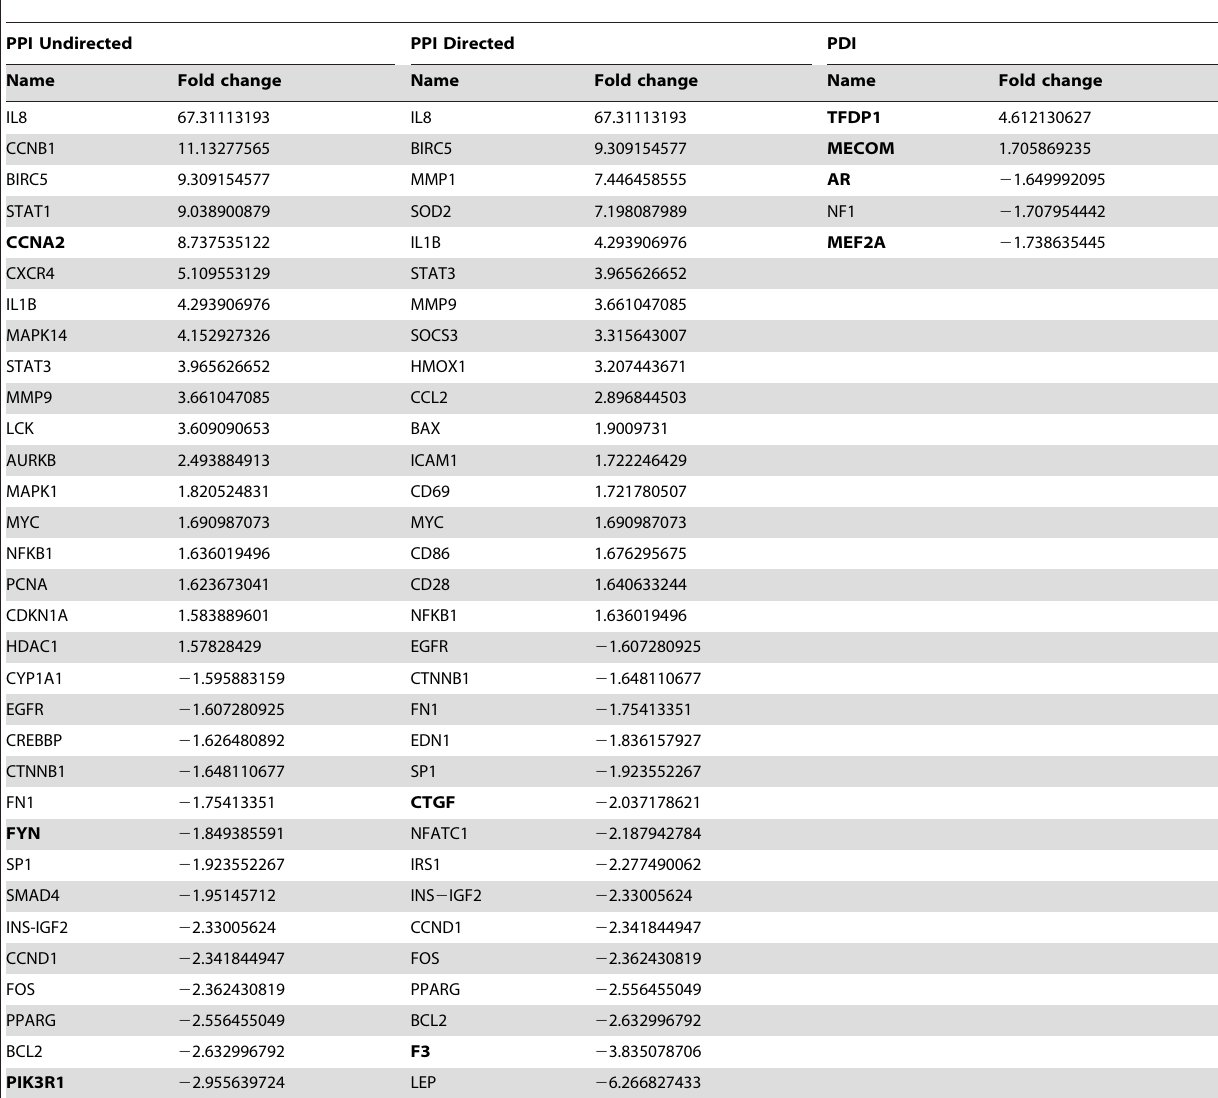
Table 4. Top rated nodes in DEG-derived